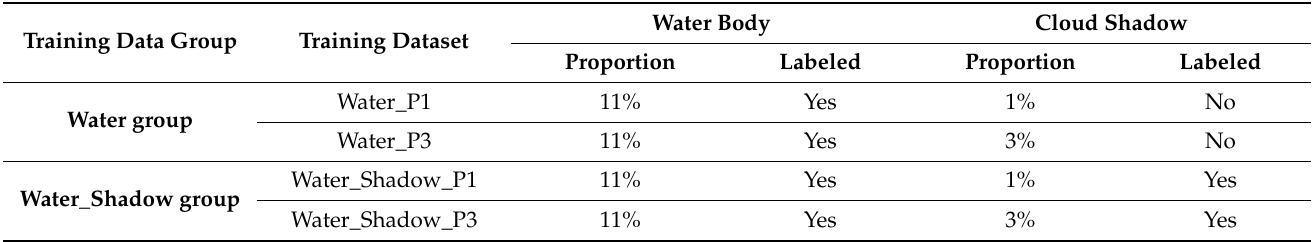
Table 1. Training dataset settings.